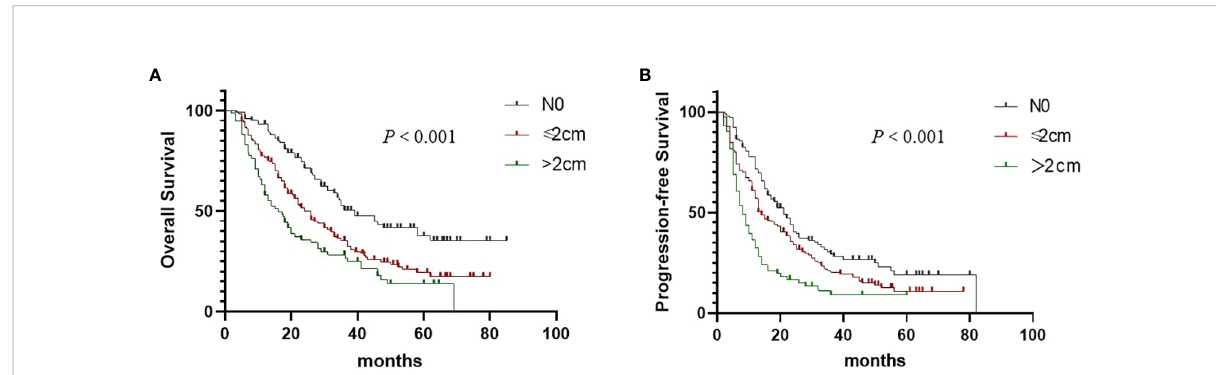
FIGURE 1 Overall survival (A) and Progression-free survival (B) in non – small cell lung cancer patients according to the size of metastatic lymph nodes.